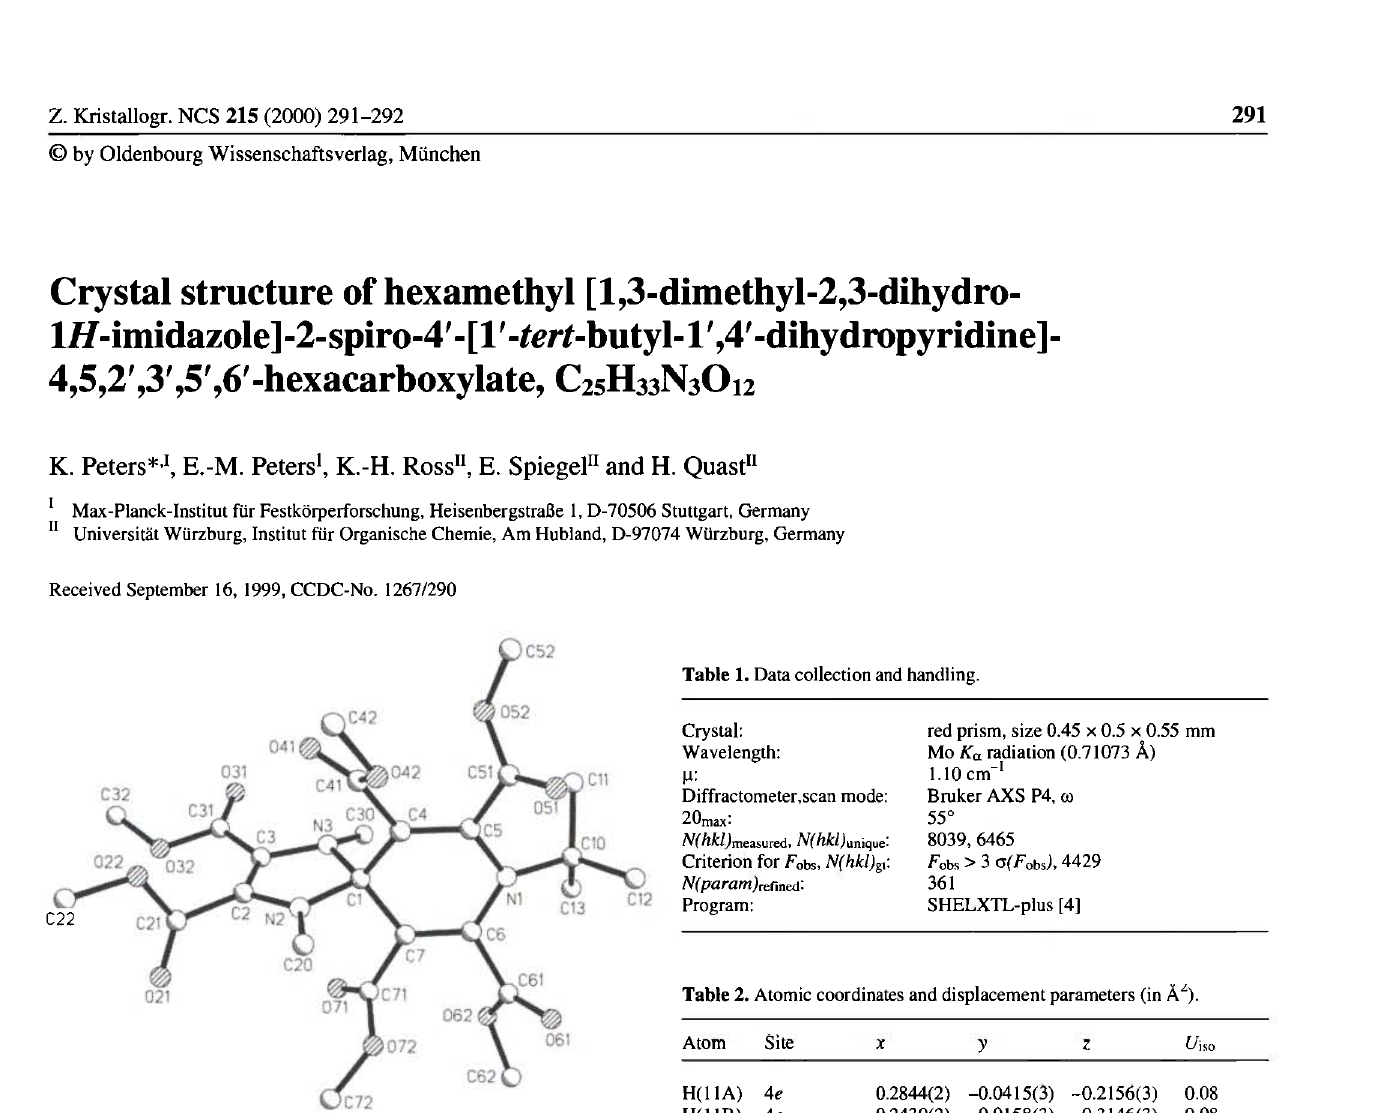
Table 2. Atomic coordinates and displacement parameters (in A